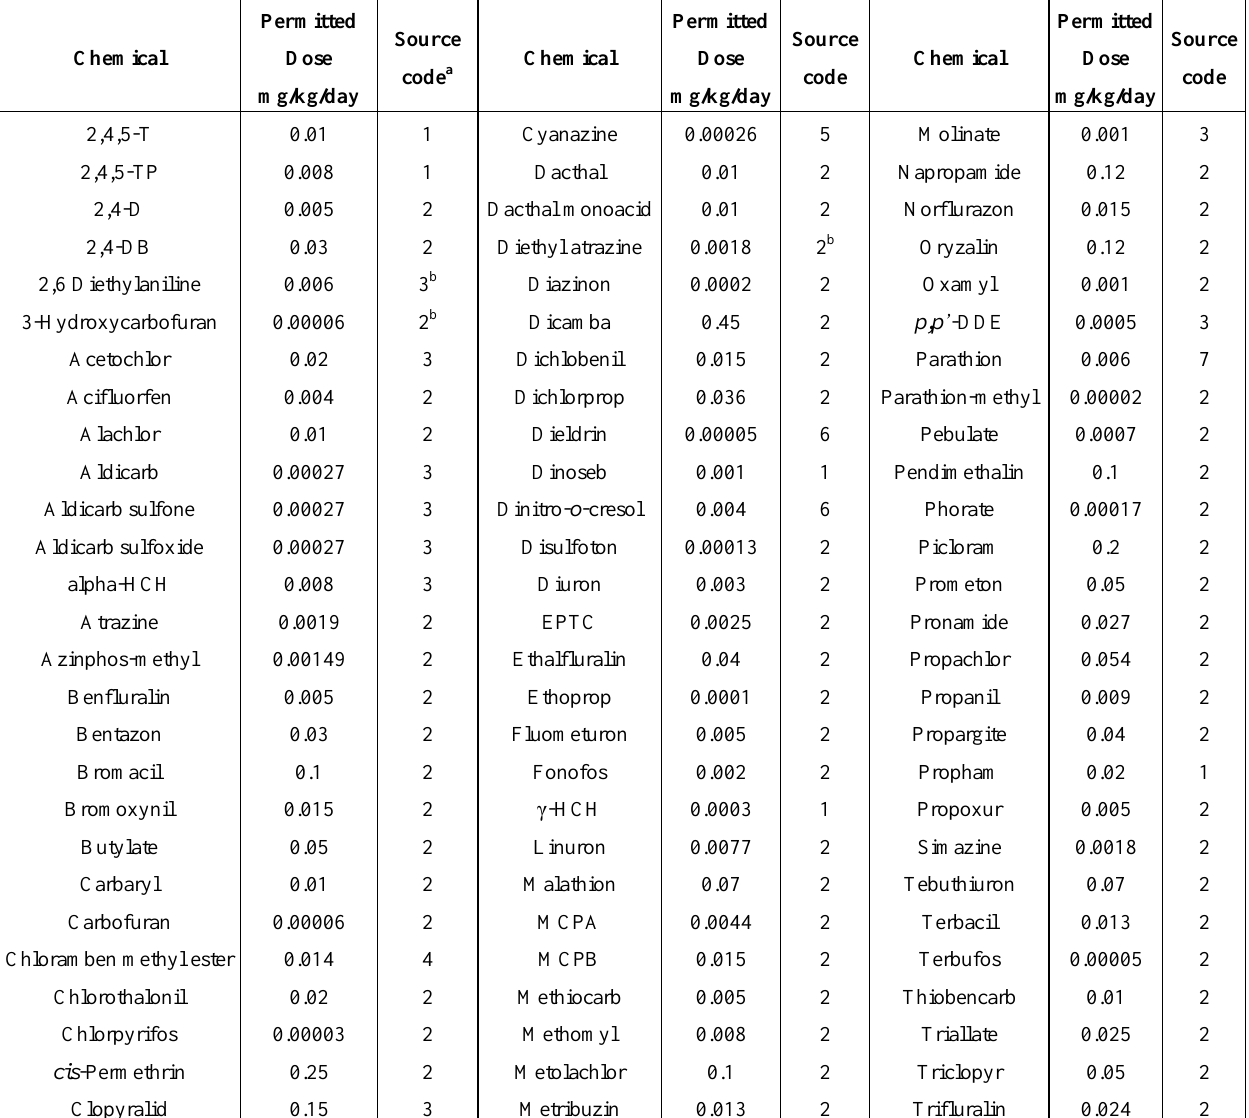
Table 1. Chronic toxicity standards for chemicals measured in surface water